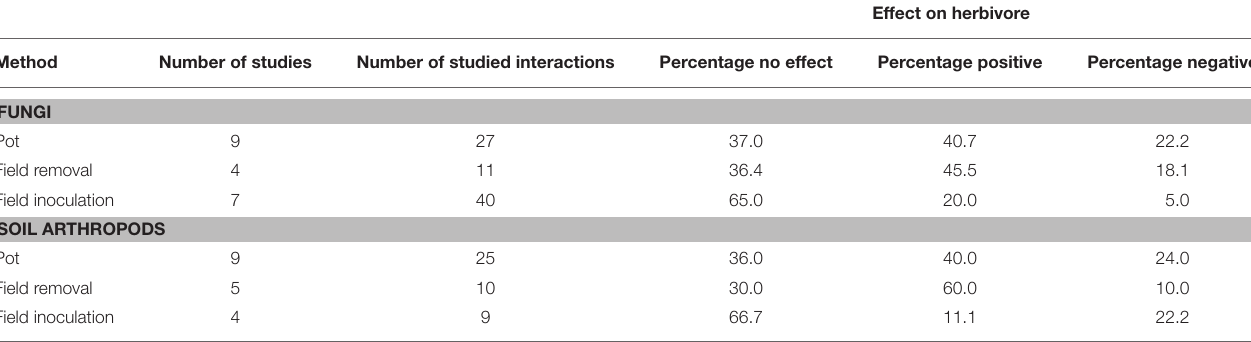
TABLE 1 | Comparison of the three most widely used field methodologies in studies investigating above-belowground interactions (potted plants placed in the field, inoculation of soil organisms in experimental plots, species removal by means of pesticides in experimental